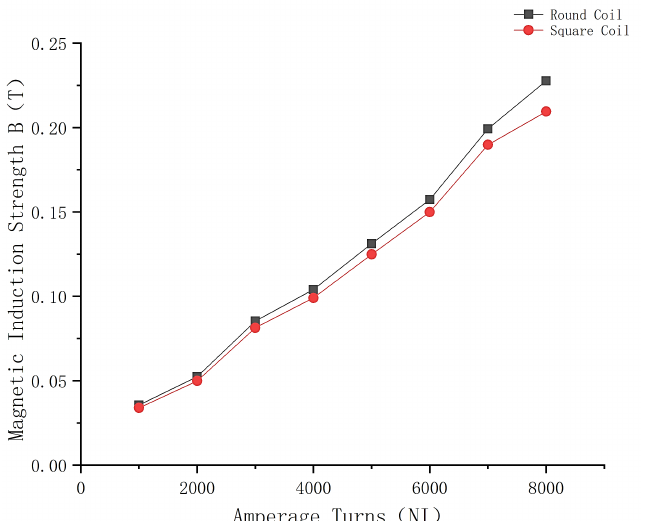
Figure 4. Comparison of the variation curves of the magnetic induction intensity at the center of different types of coils.